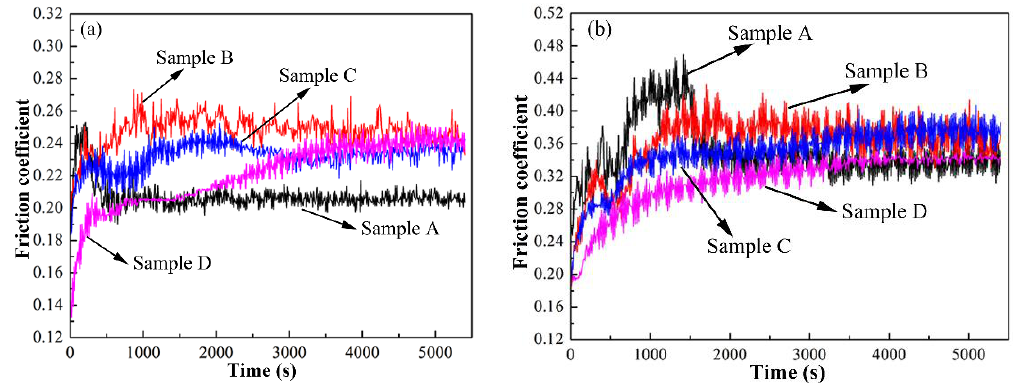
Figure 12. Friction coefficient of coatings with different load. ( a ) High load; ( b ) Low